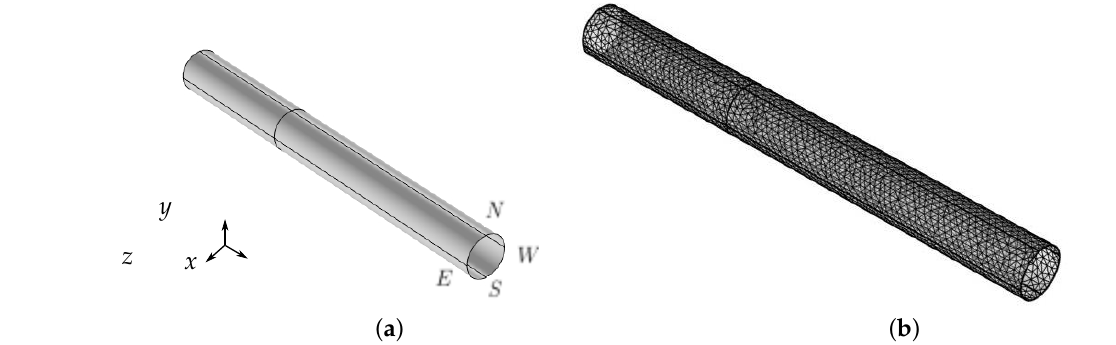
Figure A1. FE model: ( a ) sketch of the tubular structure; ( b ) representation of the adopted mesh. The structure is thus modeled as an assembly of shell elements (quadratic serendipity), and a convergence sensitivity study has been conducted (results not shown here) to find a suitable compromise between the solution accuracy and computational burden, leading to a mesh of 5040 elements that is represented in Figure